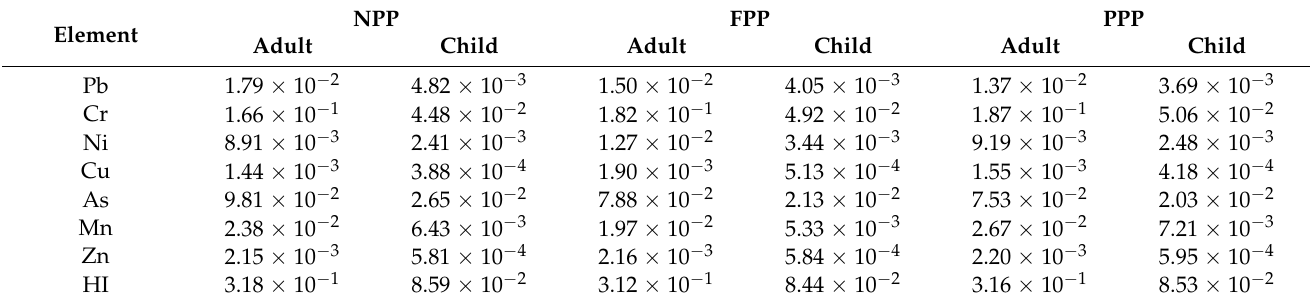
Table 4. Calculated HQs and HIs for adults and children due to oral exposure to heavy metals in the water of different subsidence